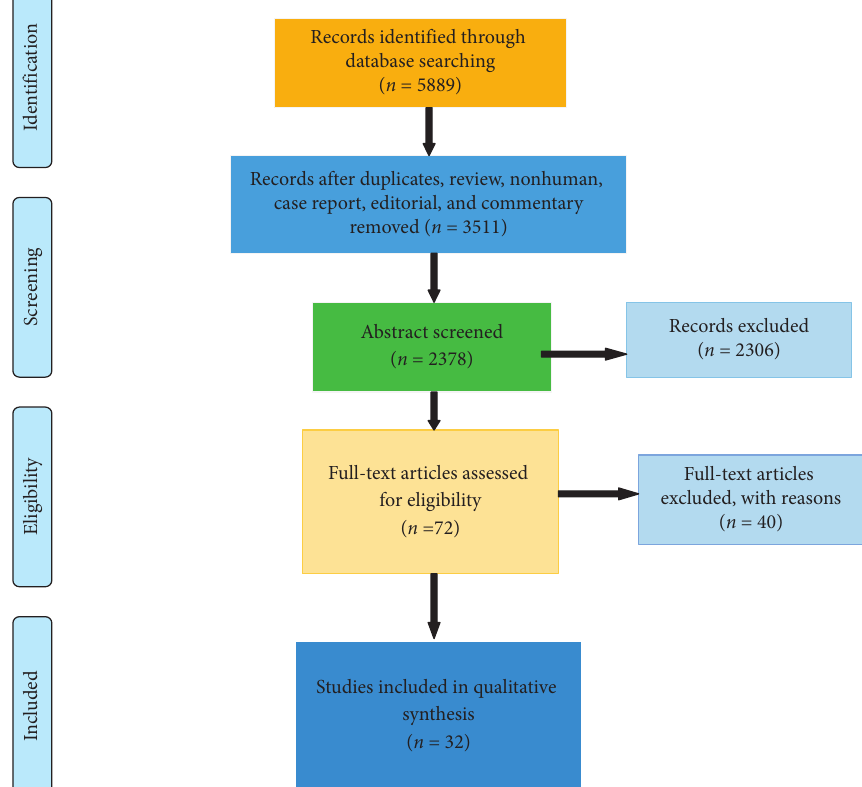
Figure 2: PRISMA flow chart diagram of search strategy and selection of the